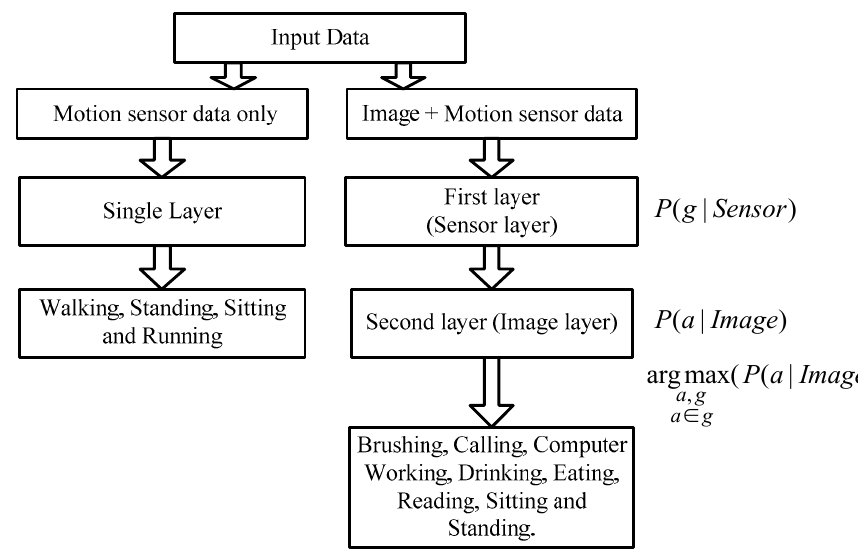
Figure 4. The proposed hierarchical method.